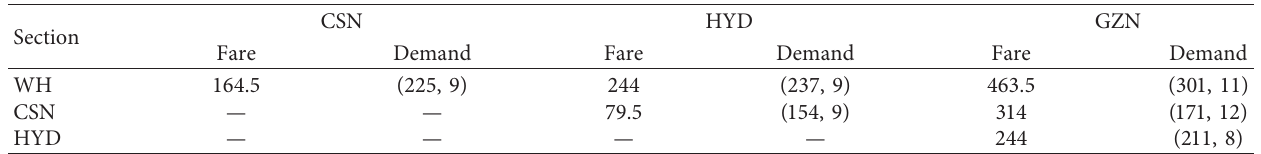
Figure 11: RMSE comparison of two kinds of prediction results. Table 3: Ticket booking in different OD